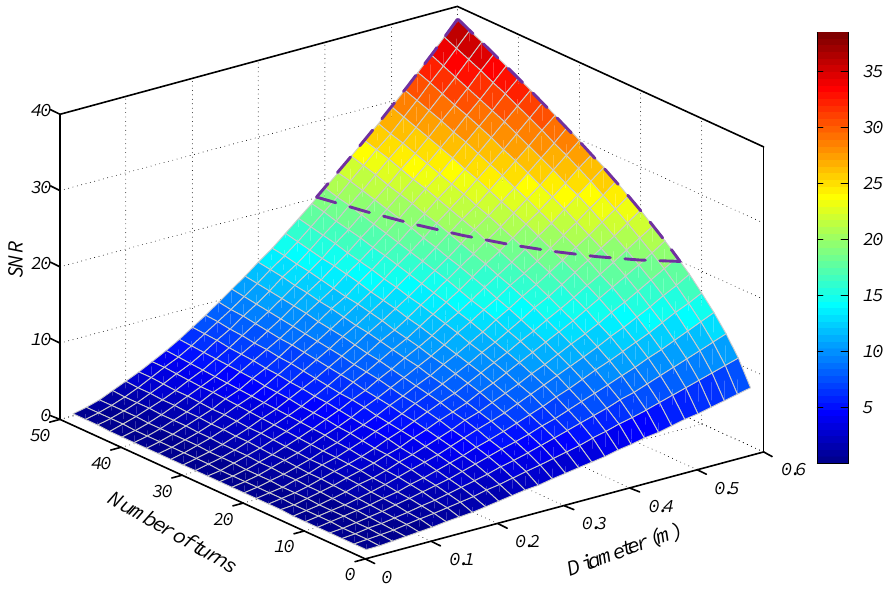
Figure 5. Contour map of the air-core coil SNR versus its n and D .